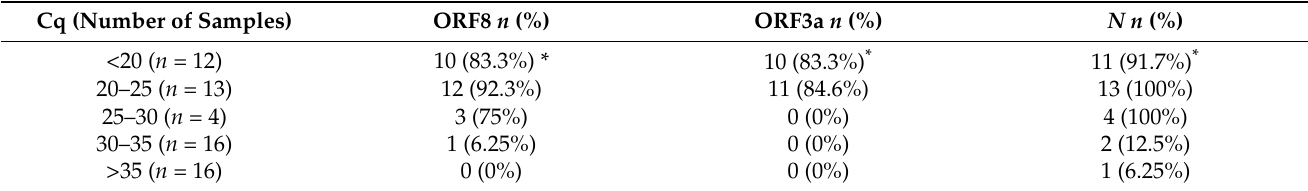
Table 3. Percentage of positive results for the RT-LAMP targets in different Cq value